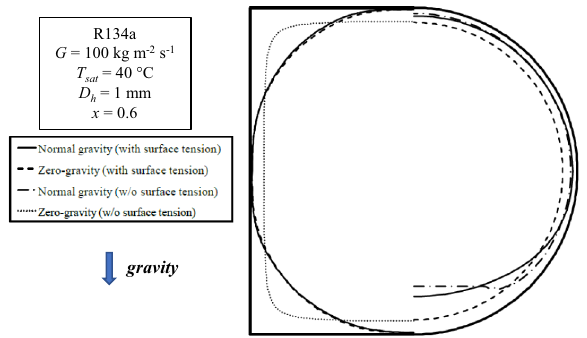
Fig. 5 Effect of surface tension and gravity on the liquid phase distribution in square and circular channels. Liquid – vapor inter- face during condensation of R134a under capillary and gravity forces resulting from VOF simulations in circular and